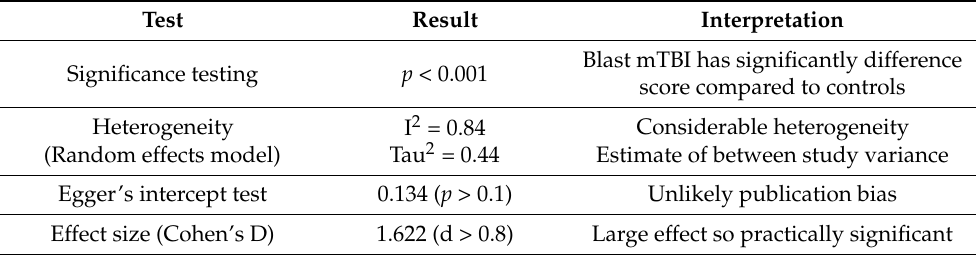
Table 3. Summary of meta-analysis